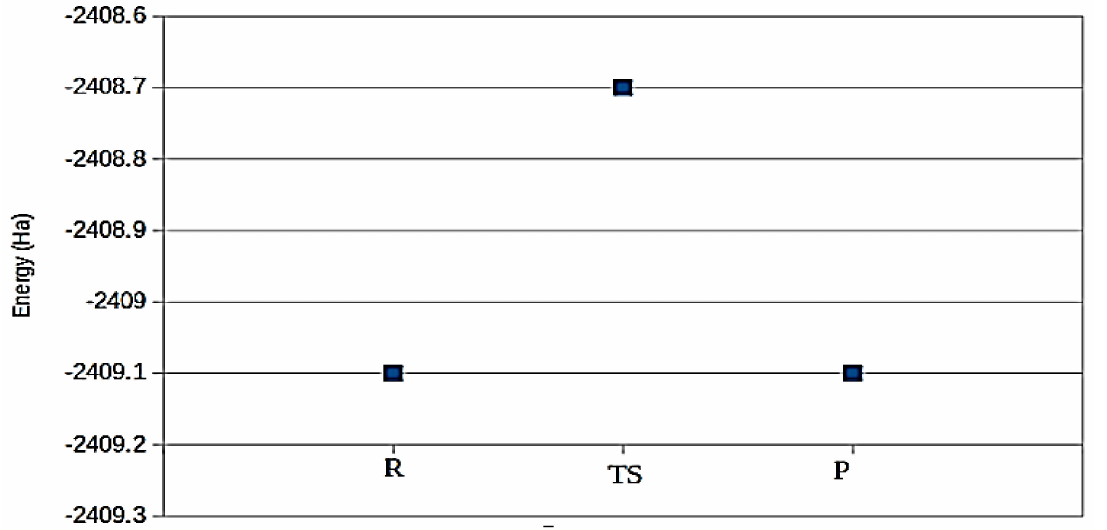
Figure 9. The main energies along the reaction line are from the reactant state (R), through the tran − sition state (TS), to the product state (P). The structures corresponding to these states are shown in Figure 10.